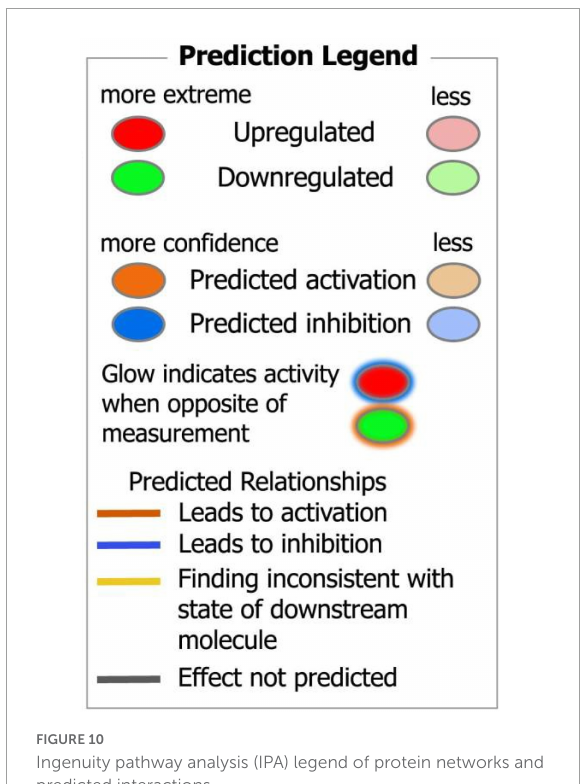
FIGURE10 Ingenuity pathway analysis (IPA) legend of protein networks and predicted